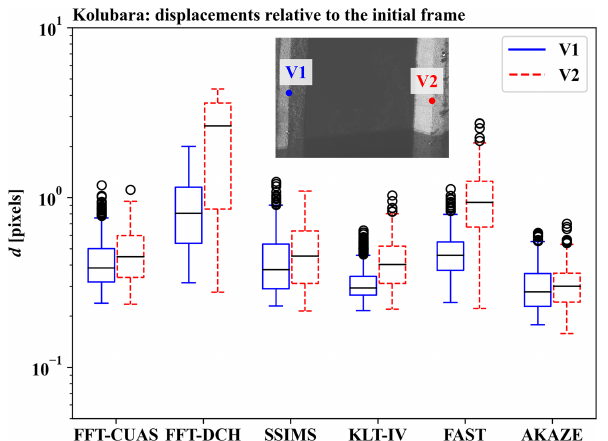
Figure 13. Displacements of validation points relative to their posi- tions in the initial frame for the Alpine river case study.